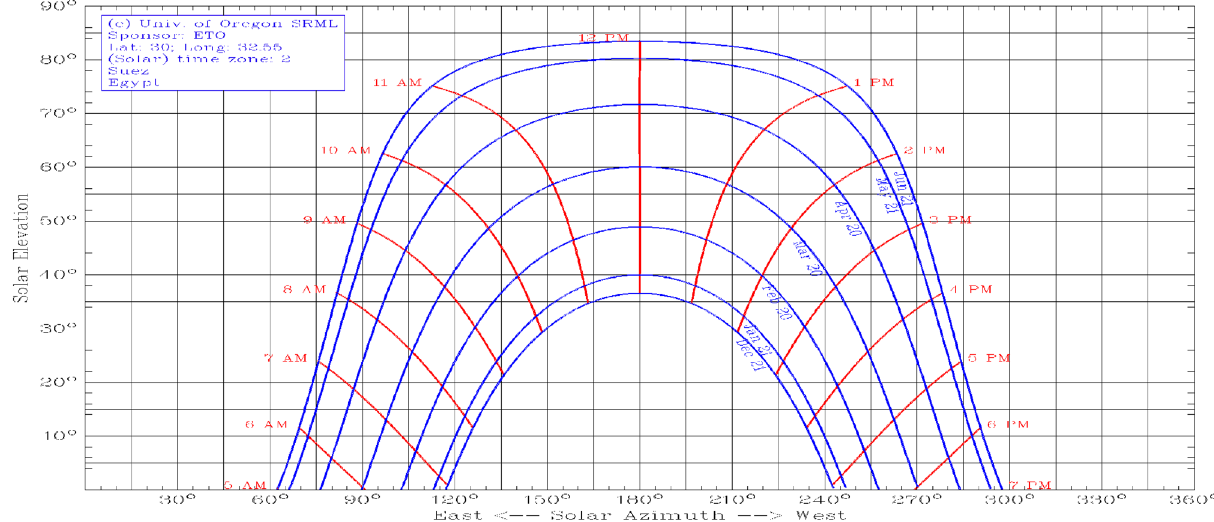
Figure 1. Sun-paths for Suez